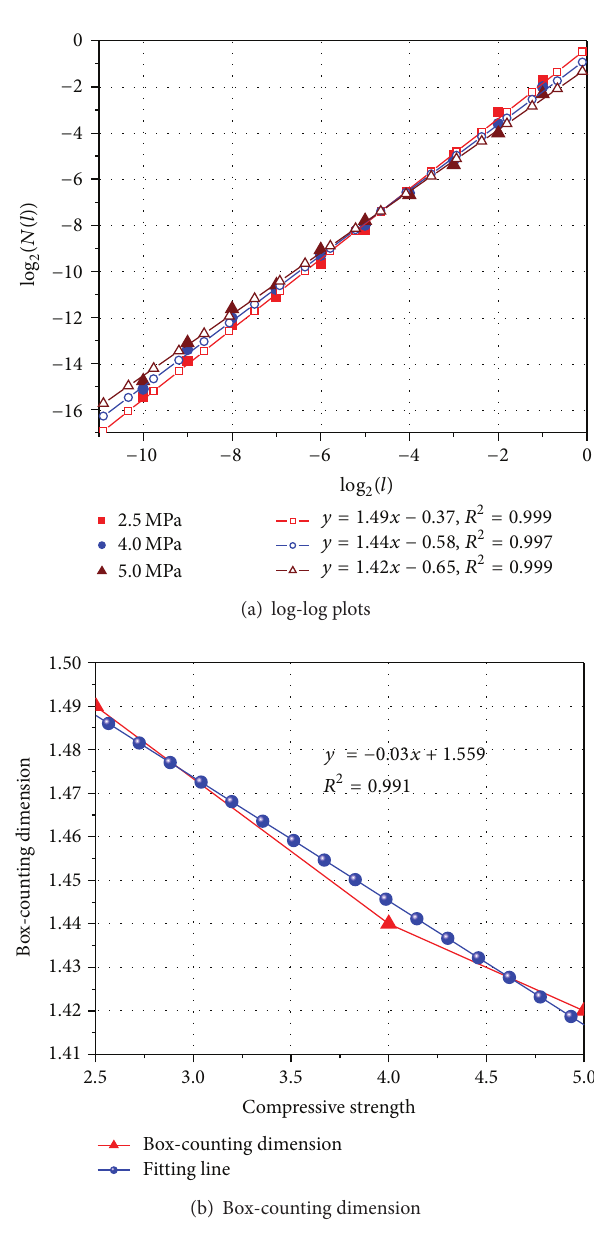
Figure 7: Box-counting dimension of cutting load under different compressive